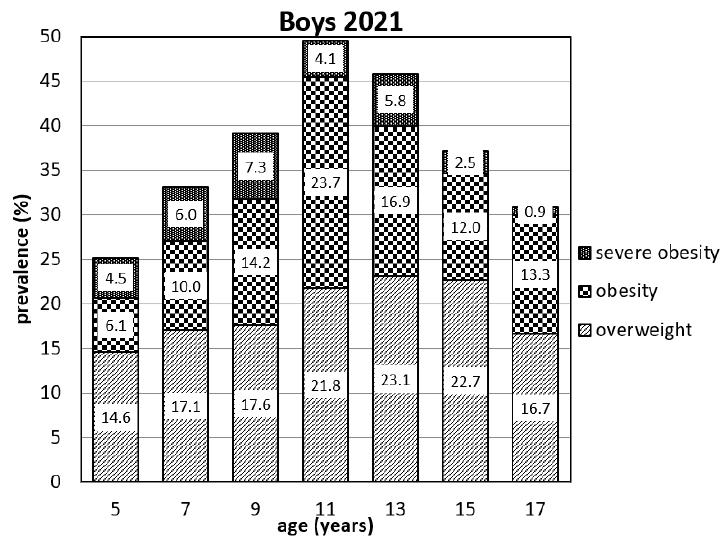
Figure 1. Prevalence of overweight, obese, and severely obese boys in 2021.